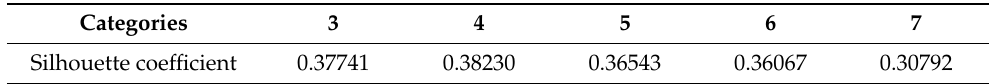
Table 4. Silhouette coefficients of different